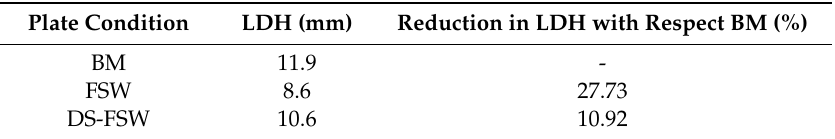
Table 1. Limiting dome height (LDH) values obtained by hemispherical punch tests on base material and joints obtained by conventional FSW and DS-FSW